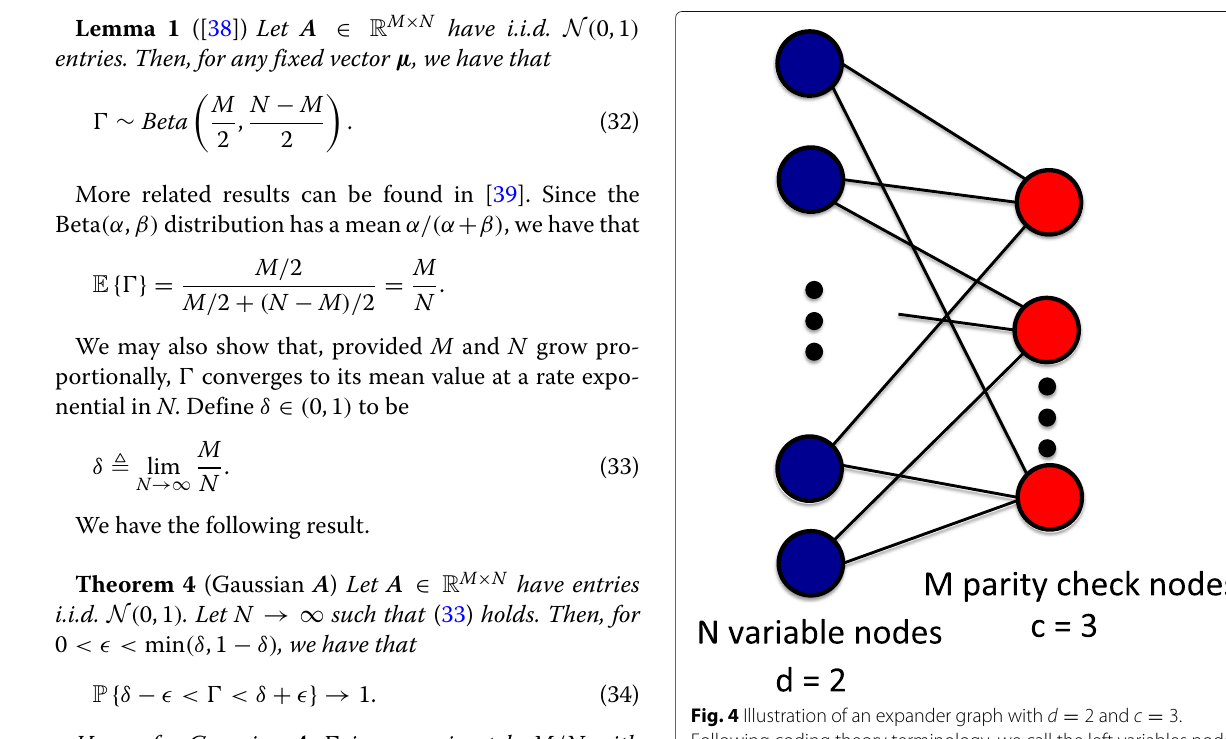
Lemma 2 ([40]) For any fixed (cid:21) > 0 and ρ (cid:2) M / N < 1